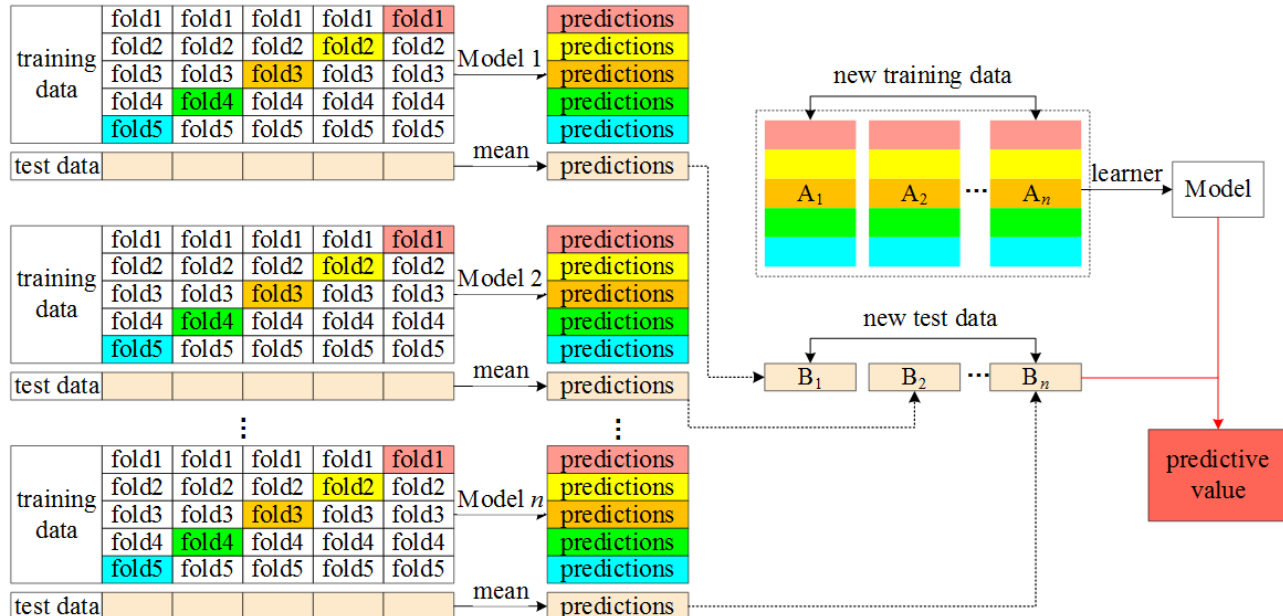
Figure 3. Schematic diagram of stacking algorithm workflow.